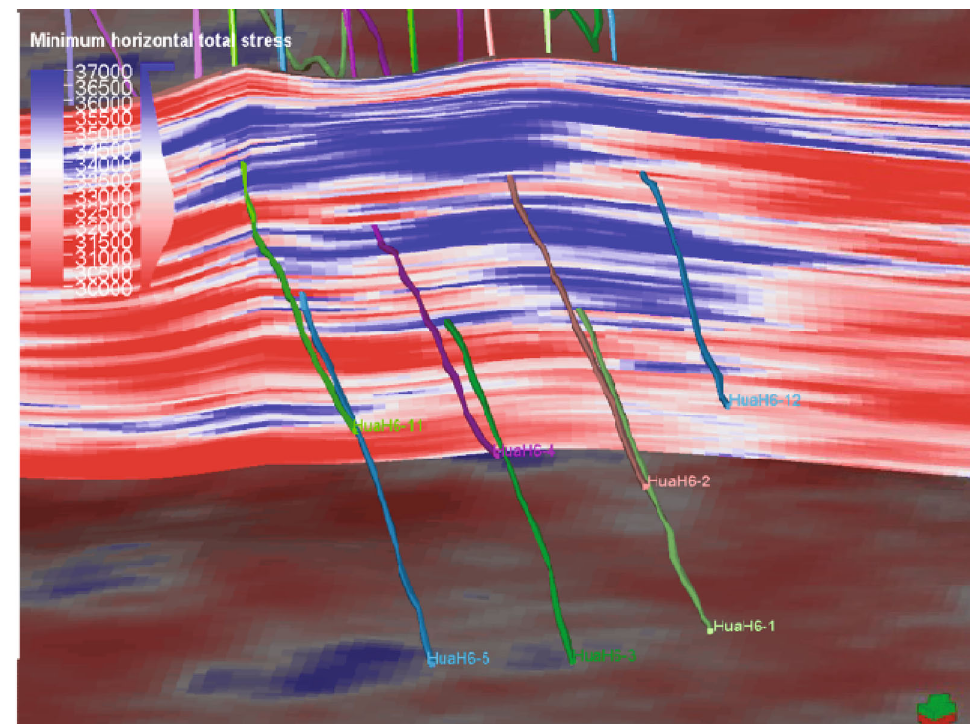
Figure 10: 3D distribution of the X platform.